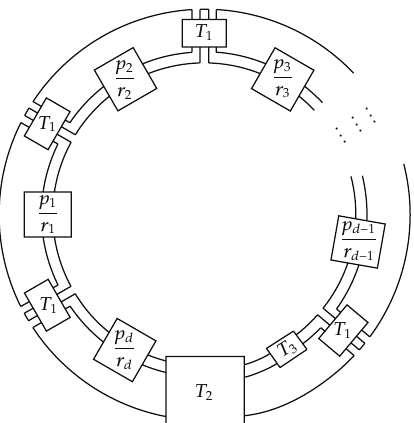
Figure 6: The branched links obtained by the Montesinos